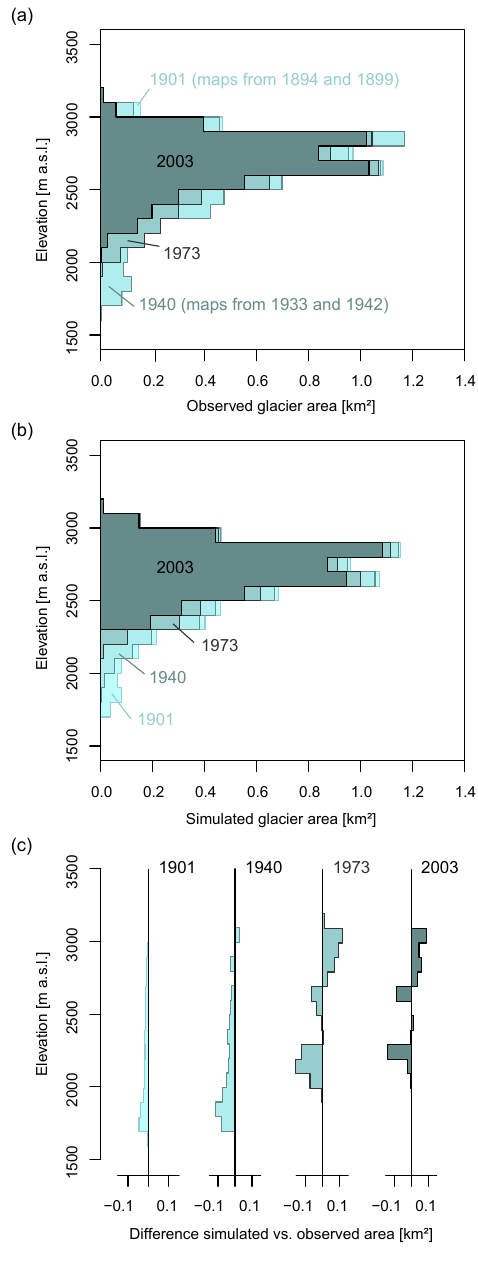
Figure 3. Observed and simulated glacier areas per elevation zone for years for which historical maps or glacier inventories are avail- able: (a) glacier areas for the different elevations derived from maps or remote sensing, (b) glacier areas for the different elevations as simulated with the full new GACR model version, and (c) differ- ences between glacier areas from simulation and reference datasets.